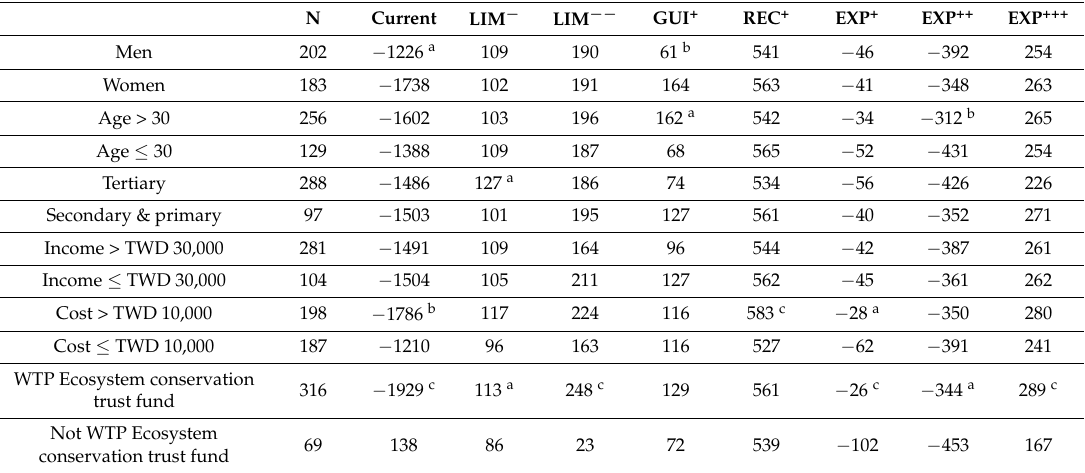
Table 5. The differences in WTP of Orchid Island visitors from different socioeconomic backgrounds. N